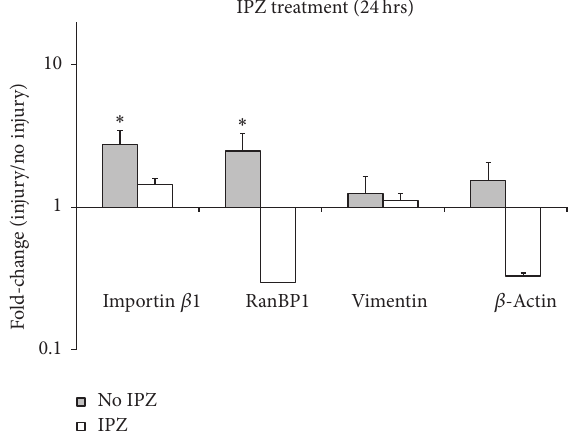
Figure 6: Inhibition of nuclear transport results in downregulation of axonal transcriptional changes. Real-time RT-PCR was used to measure levels of axonal mRNA in injured hippocampal axons after inhibiting nuclear transport with IPZ. IPZ treatment suppresses elevated importin 𝛽 1, RanBP1, vimentin, and 𝛽 -actin mRNA levels (white bars). Grey bars (previously graphed in Figure 2, 24 hrs) indicate untreated axons and are included for clarity of comparison. Error bars represent the SD. ∗ indicates significant difference of IPZ treated and untreated cells from their corresponding controls ( p < 0.05) based on pairwise fixed allocation test. 𝑁 = 3 for all groups, except for Ranb1 (see Section